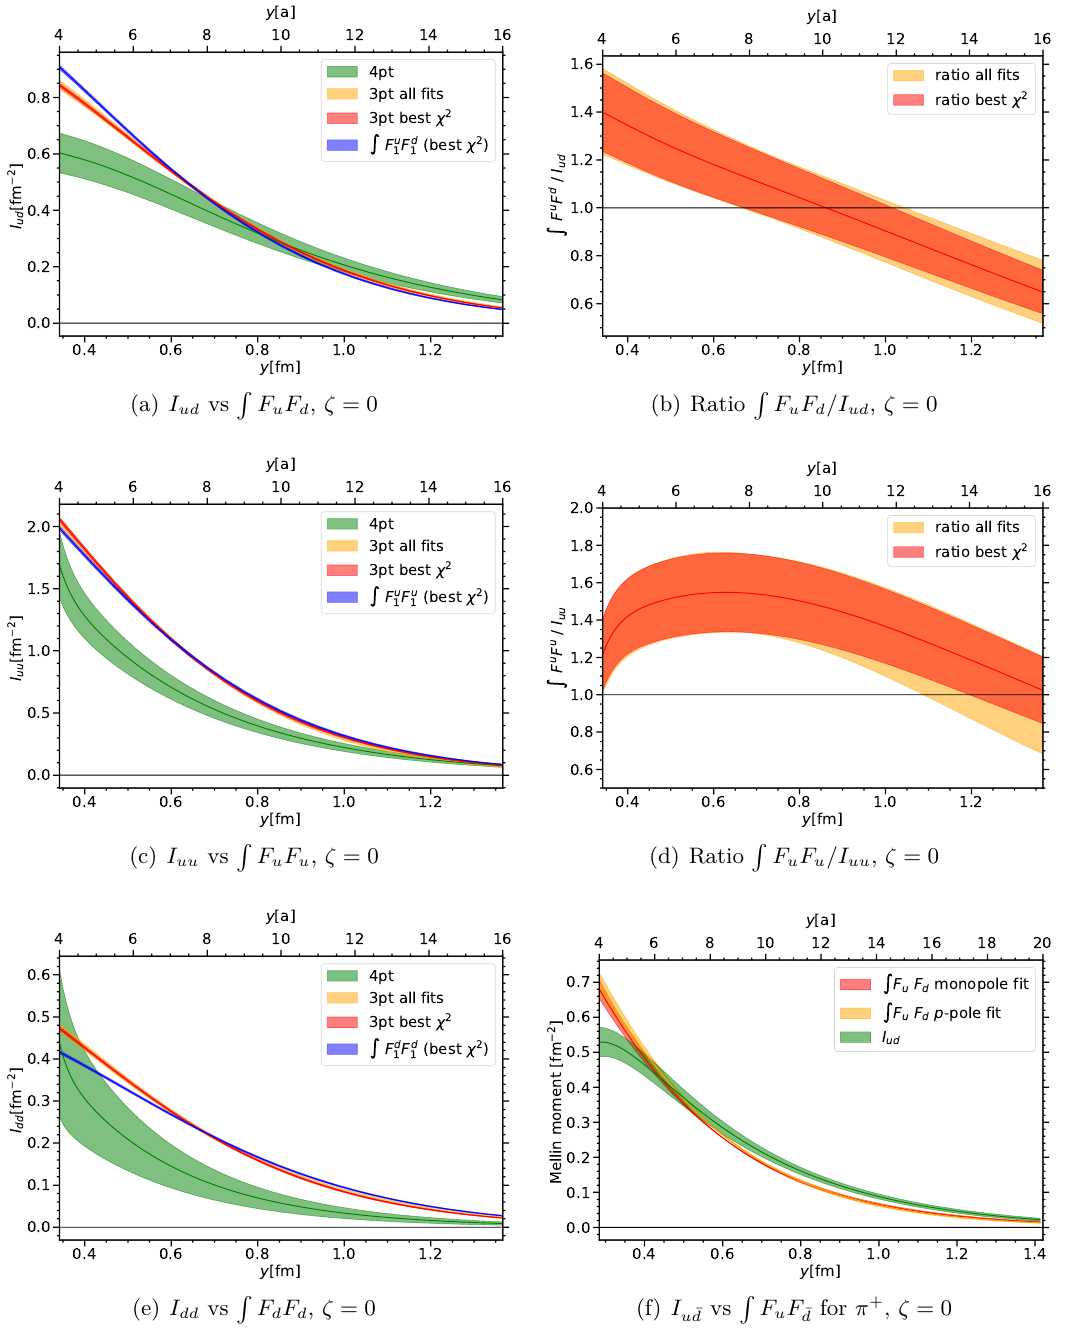
Figure 29 . Mellin moment I ud at ζ = 0 compared to its factorized result obtained from the corresponding integral (5.10) (a) and the ratio of the integral and the Mellin moment (b). The same is plotted for I (c,d) and I (e). For the latter the ratio is not shown. The orange curve uu dd shows the envelope of the error bands for every fit. The result of a integral where only the first term in (5.10) is taken into account is represented by the blue curve. Panel (f) shows the factorization result for I in the π + obtained in [67] for the two form factor fits considered in that u ¯ d